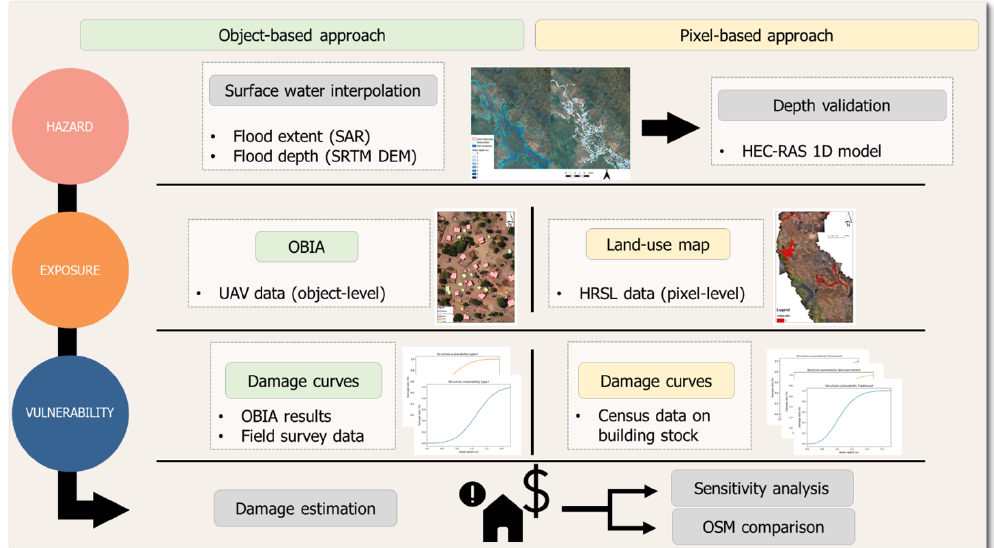
Figure 3. Workflow of the two approaches of flood damage estimation. The left panel shows the object-based approach, and the right panel shows the pixel-based approach. Abbreviations: synthetic aperture radar (SAR), Shuttle Radar Topography Mission (SRTM) digital elevation model (DEM), object-based image analysis (OBIA), High-Resolution Settlement Layer (HRSL) and OpenStreetMap (OSM). The inundation (hazard) map is shown on a © Google Satellite image. The OBIA and land-use maps are created using UAV imagery from the Malawi Red Cross Society.